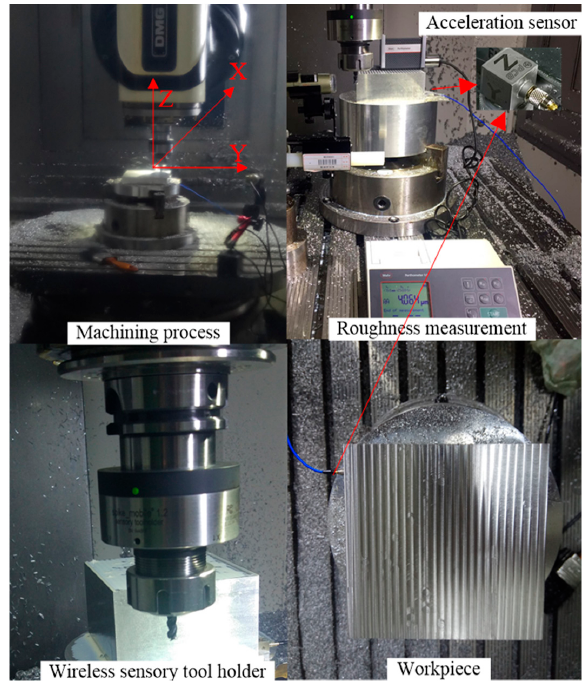
Figure 2. Experiment environment.